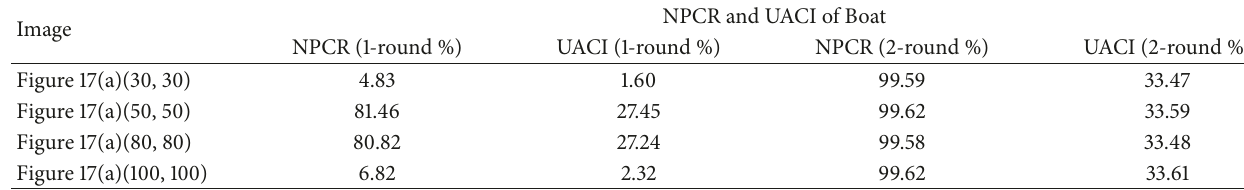
NPCR and UACI of